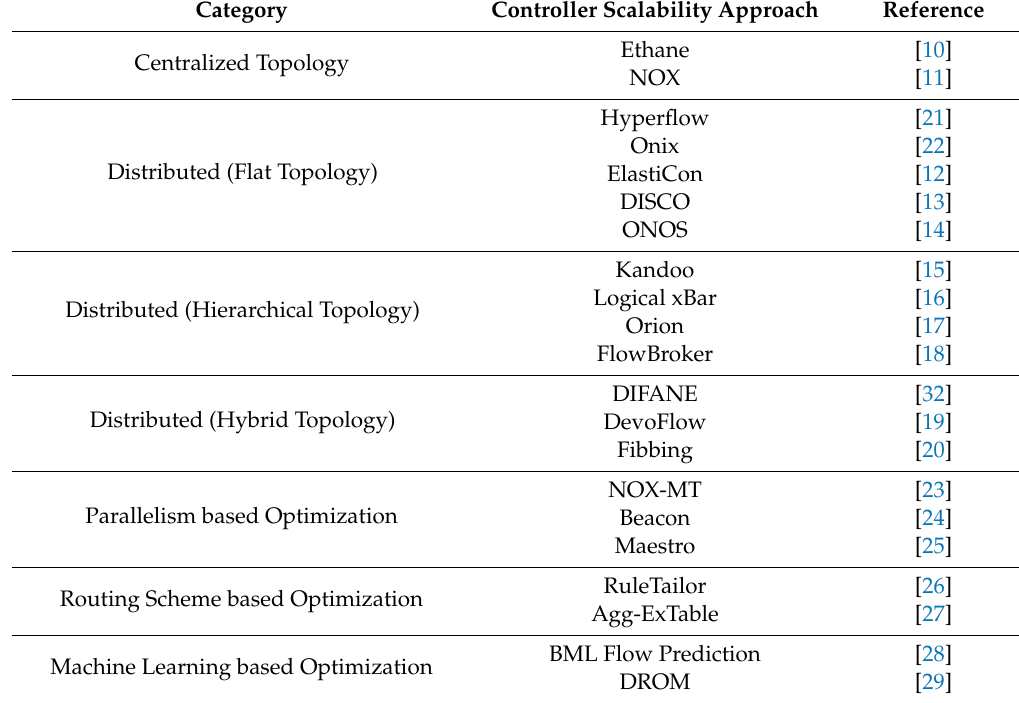
Table 1. Summary of the Control Plane Scalability Approaches.